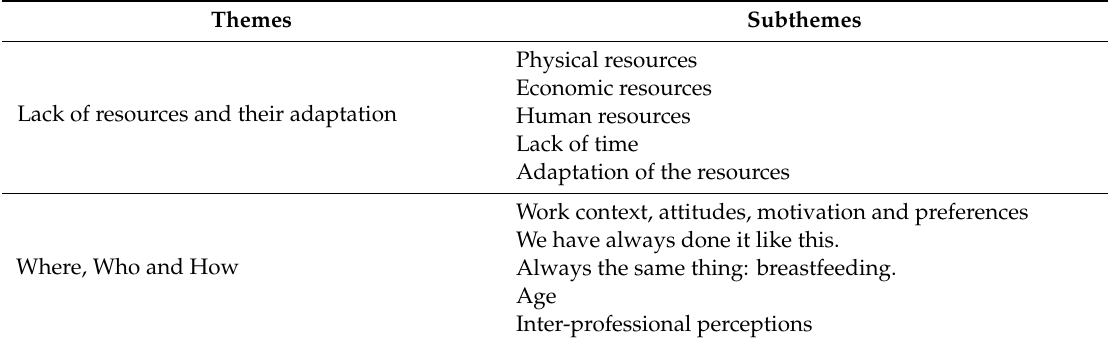
Table 2. Themes and